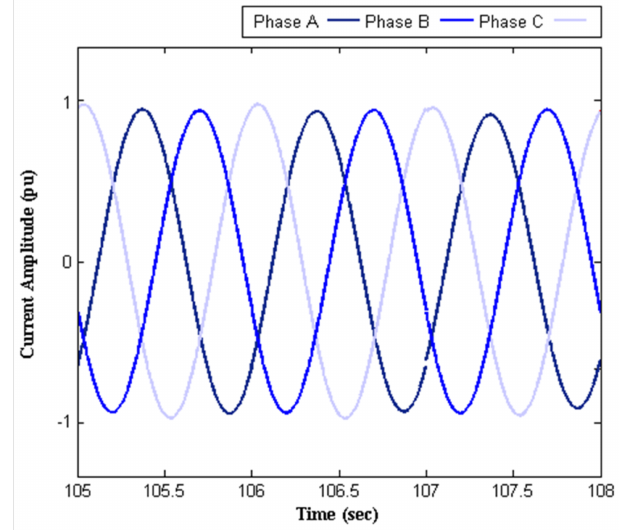
Figure 11. Network currents with SVC tunned by the proposed approach.